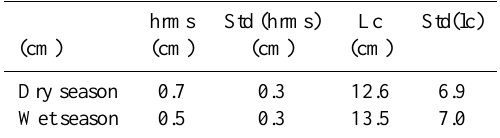
Table 3. Statistical parameters of the soil roughness at Agoufou (sandy soil) during the dry and the wet seasons: hrms is the root mean square value of the roughness height, lc is the corellation length, Std is the standard deviation.